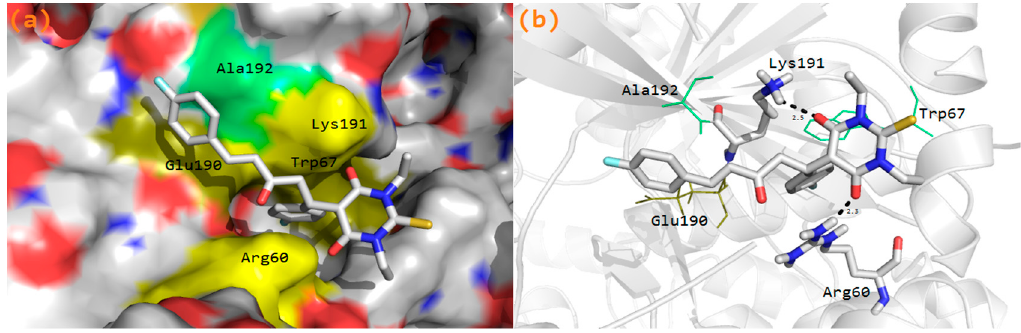
Figure 6. ( a ) Compound 3a fits to the active site cavity of GPb enzyme; ( b ) Binding conformation of compound 3a in the active site of GPb enzyme.